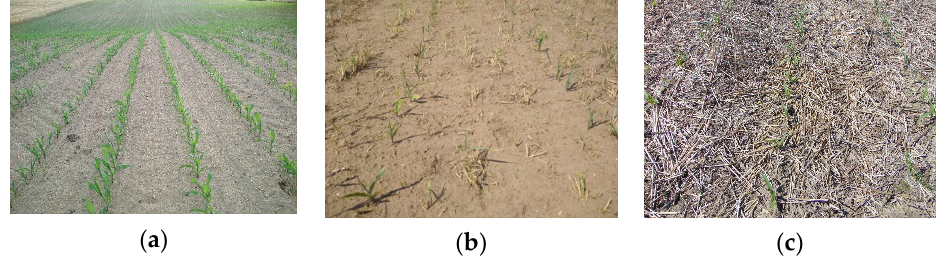
Figure 2. Maize cultivation in three soil tillage systems: ( a ) conventional tillage; ( b ) reduced tillage; ( c ) no-tillage.